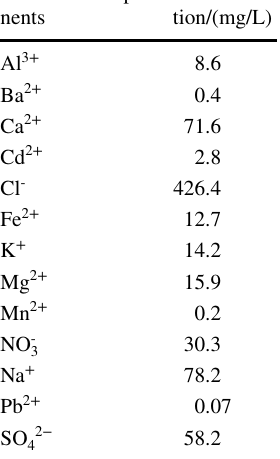
Table 1 The chemical